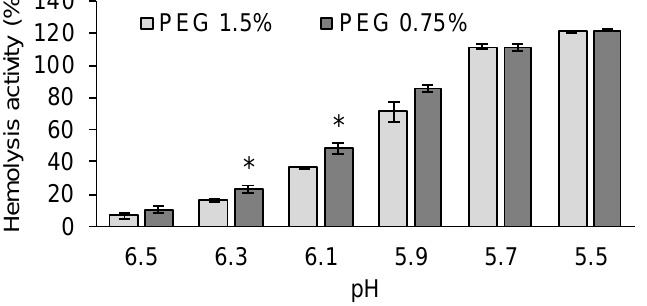
Figure 5. Hemolytic activity of the LNP ssPalm with different amount of PEG-lipids. The LNP ssPalm with 0.75% of DMG-PEG2000 or 1.5% of DMG-PEG2000 was incubated with red blood cells at different pH from pH5.5 to pH 6.5. Data were represented as mean ±SD ( n = 3). Statistical analysis was performed by student- t’s test, *; p < 0.05.